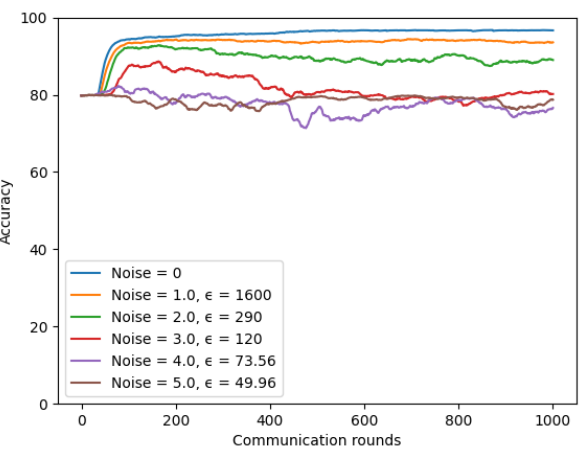
Figure 18. Differential privacy with different noise values on symptom